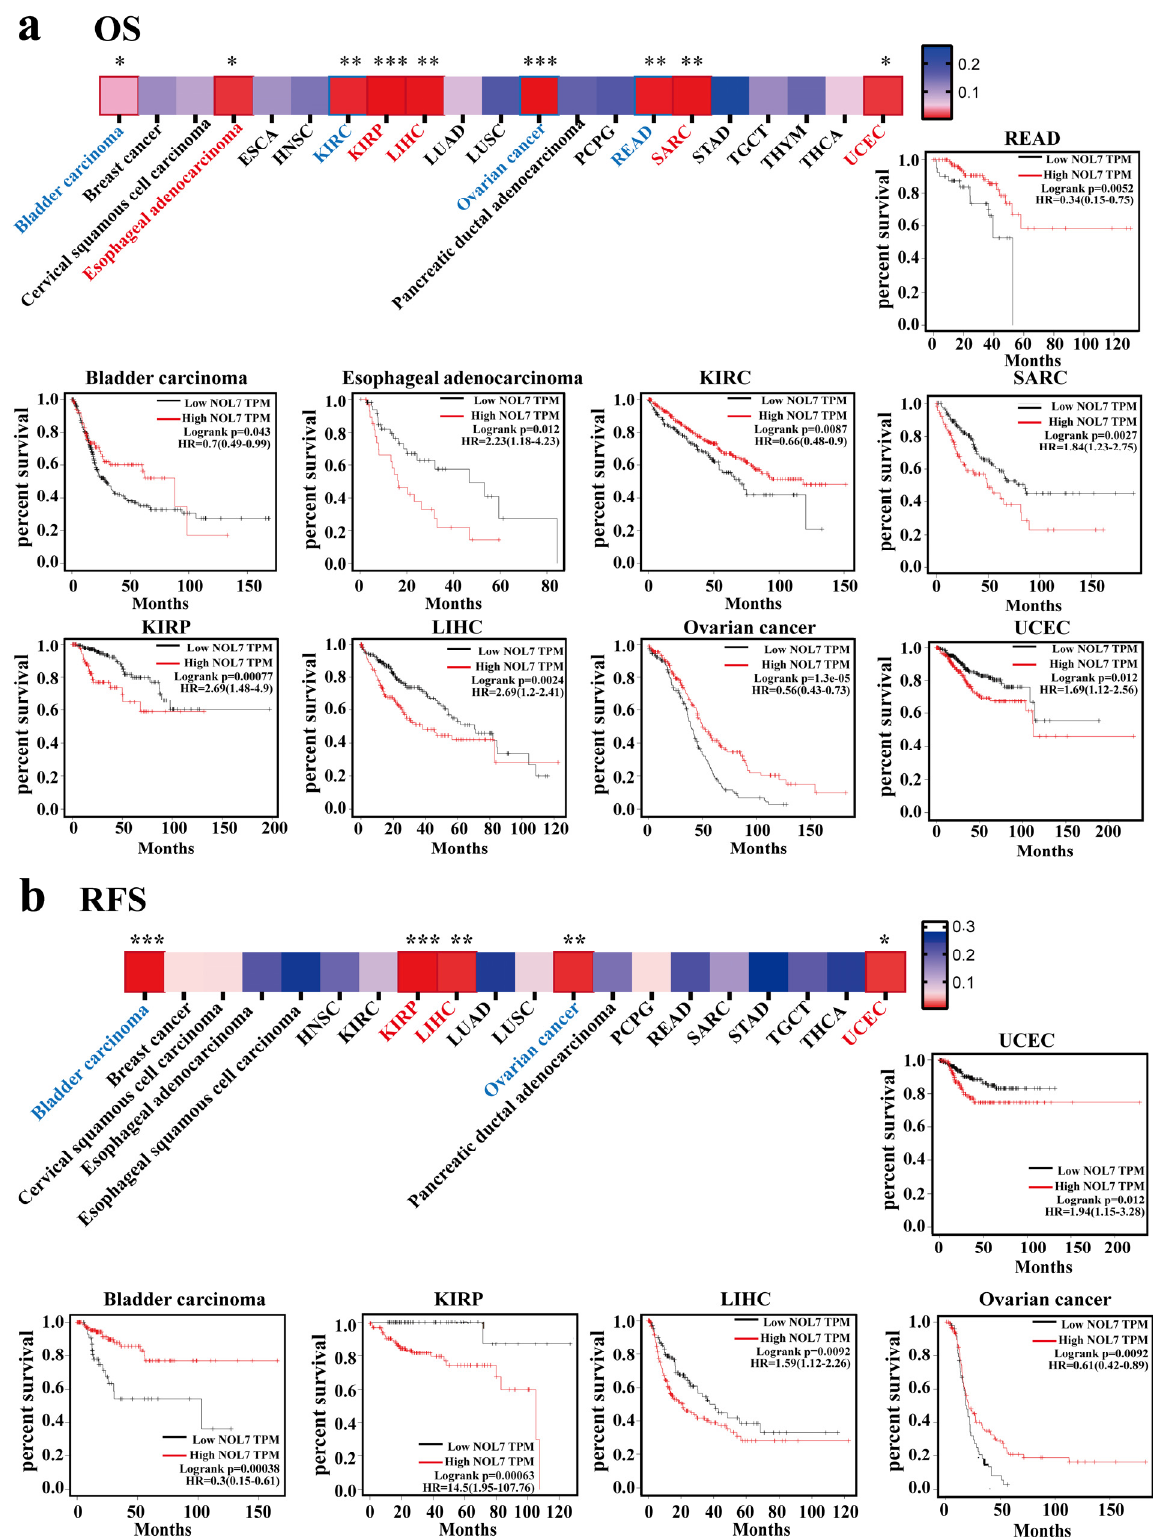
Figure 3. Survival prognoses of groups with high and low NOL7 expression levels, according to the Kaplan–Meier plotter. ( a ) Correlation of OS with NOL7 expression in bladder carcinoma, esophageal adenocarcinoma, KIRC, SARC, KIRP, LIHC, OV, UCEC, and READ. ( b ) Correlation of RFS with NOL7 expression in bladder carcinoma, KIRP, LIHC, OV, and UCEC. * p < 0.05; ** p < 0.01; *** p < 0.001.